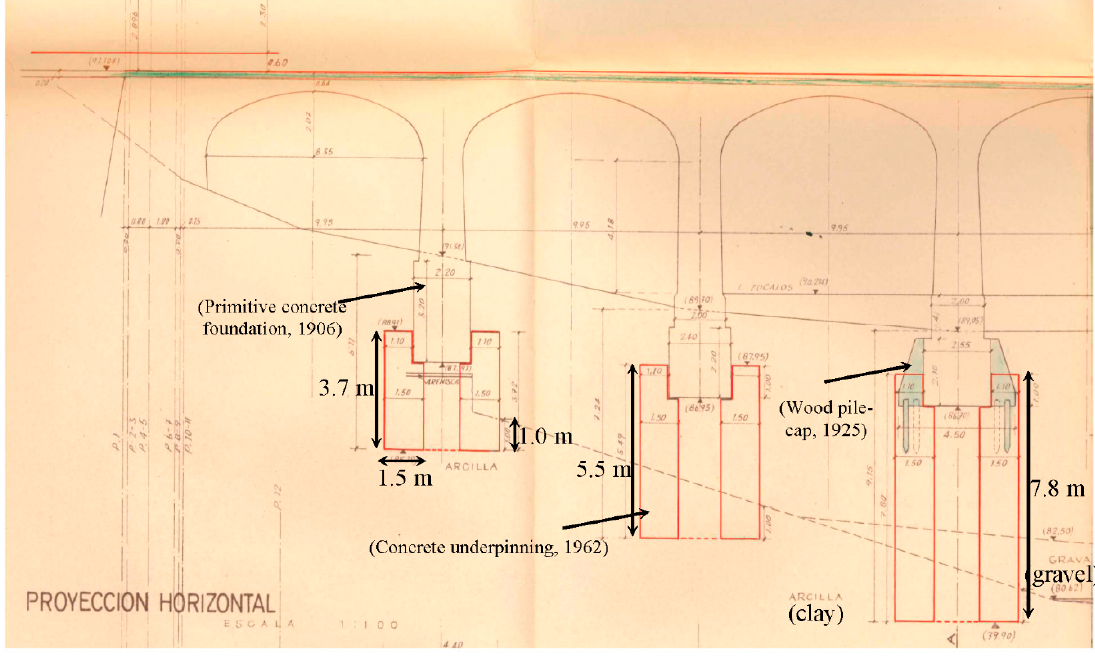
Figure 3. Capdevila aqueduct foundations (CAyC at Km 71).